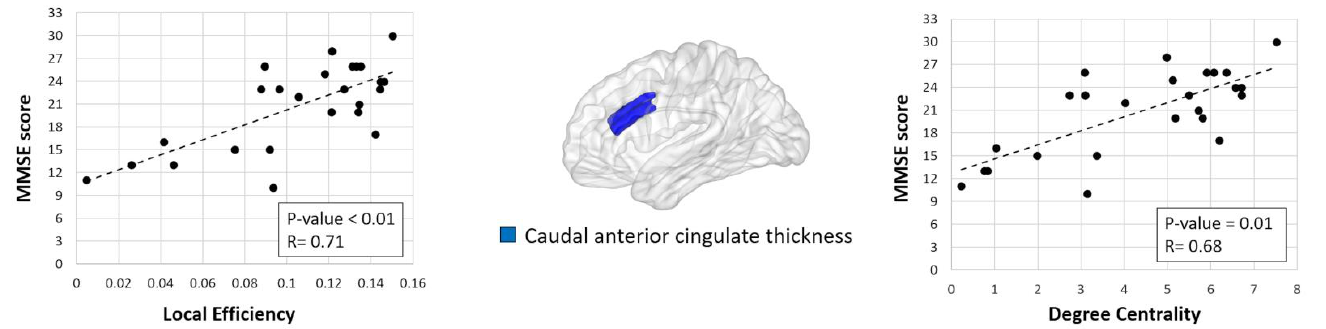
Figure 2. Significant correlation between degree centrality/nodal efficiency in the cortical thickness of the caudal anterior cingulate and Mini-Mental State Examination (MMSE) scores in behavioral variant frontotemporal dementia (bvFTD) pa- tients.